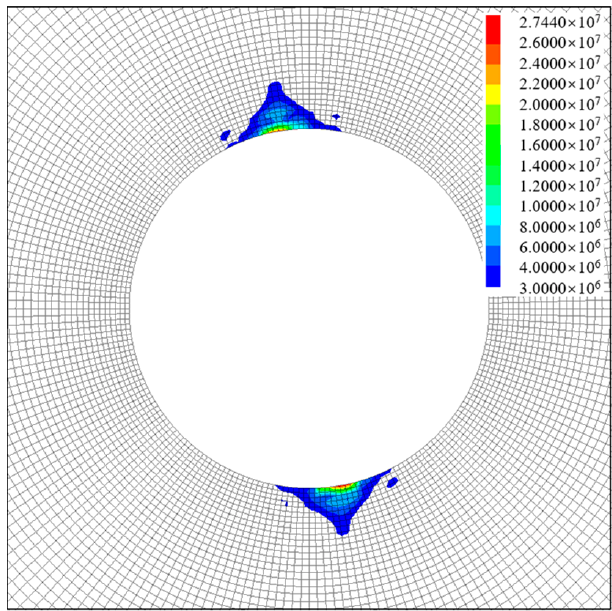
Figure 8. Local energy release effectiveness.